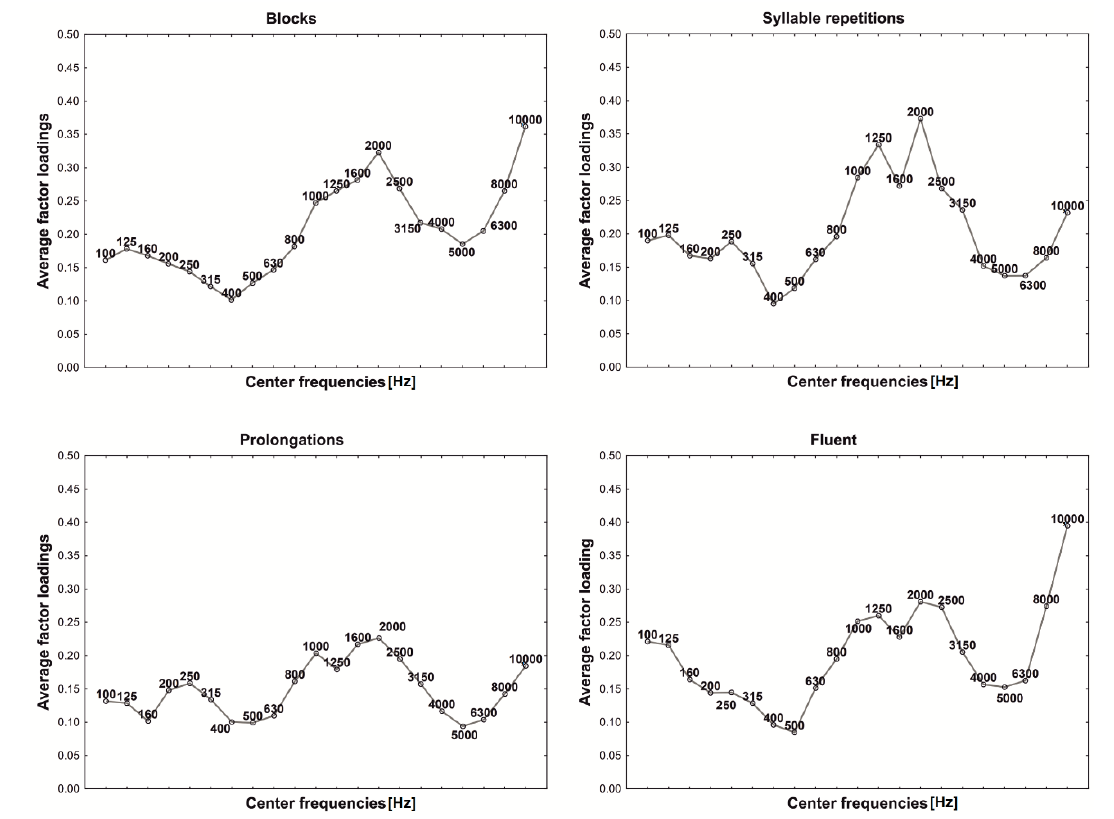
Figure 7. Fourth component (G 4 ) factor loadings.